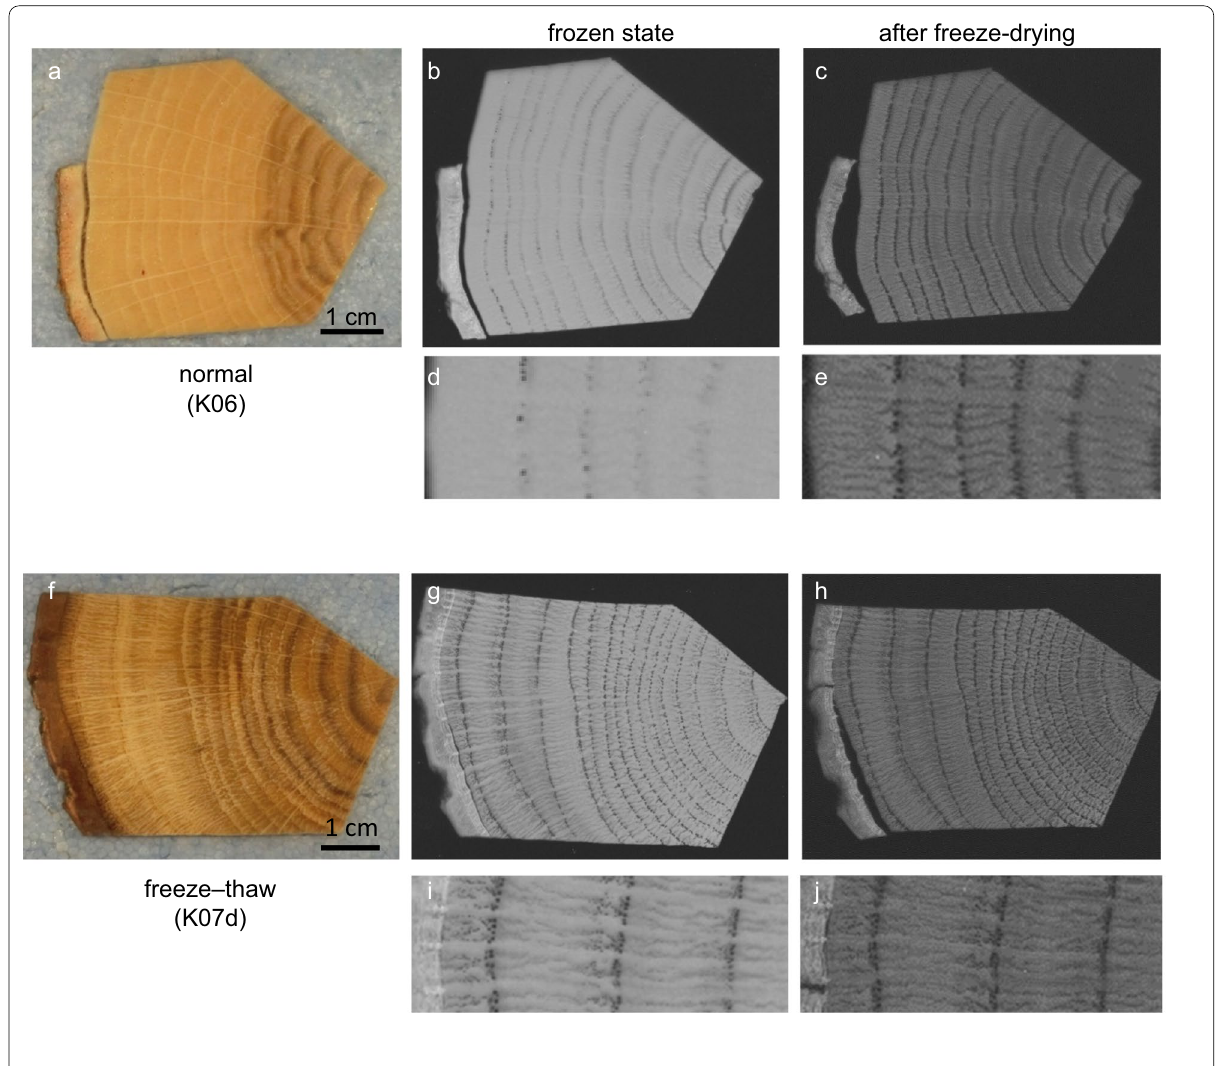
Fig. 5 Typical water distribution in a konara oak ( Quercus serrata ) trunk observed by soft X-ray photography. Optical ( a , f ) and X-ray photographs ( b – e , g – j ) of the transverse surface of controls (without Cs injection) of a normal tree (K06) and a freeze–thaw treated tree (K07b). A comparison of X-ray photographs between frozen-state wood ( b , d , g , i ) and that obtained after freeze-drying ( c , e , h , j ) reveals water distribution at the tissue level. d , e , i , and j are magnified images of b , c , g , and h ,